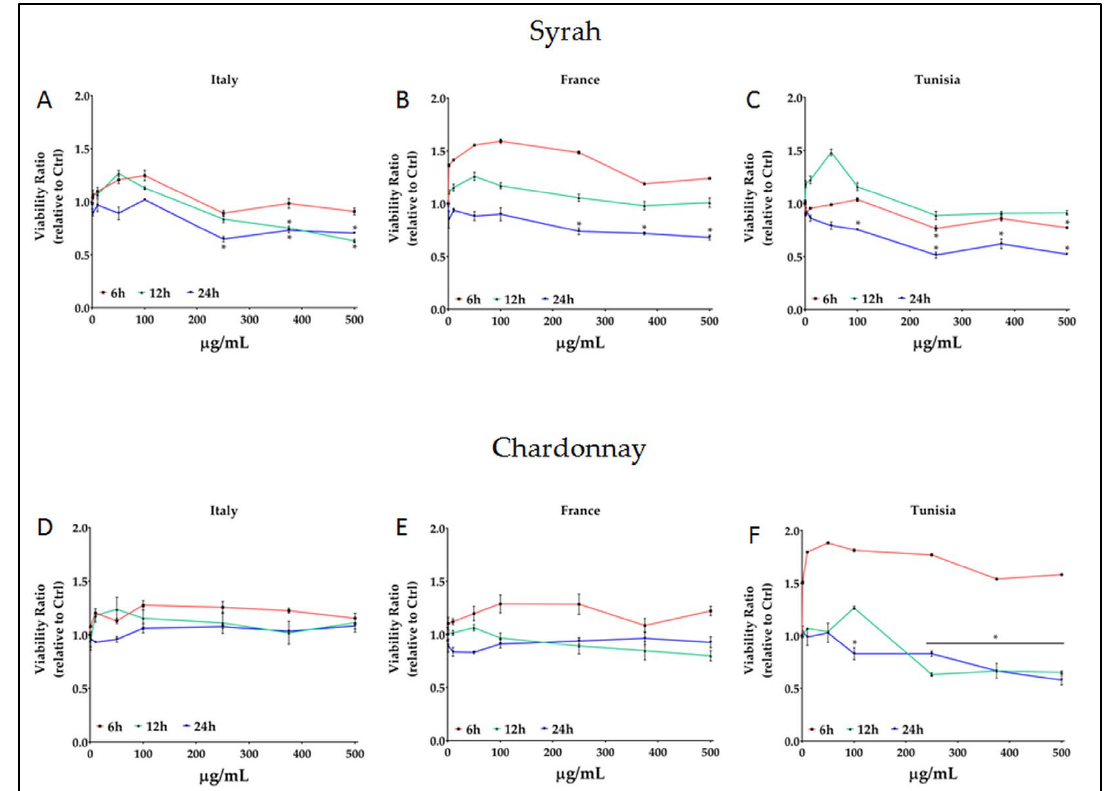
Figure 3. Effect of Syrah and Chardonnay pomace extracts on viability of B16F10 cancer cell lines. * = p ≤ 0.01 vs . control.